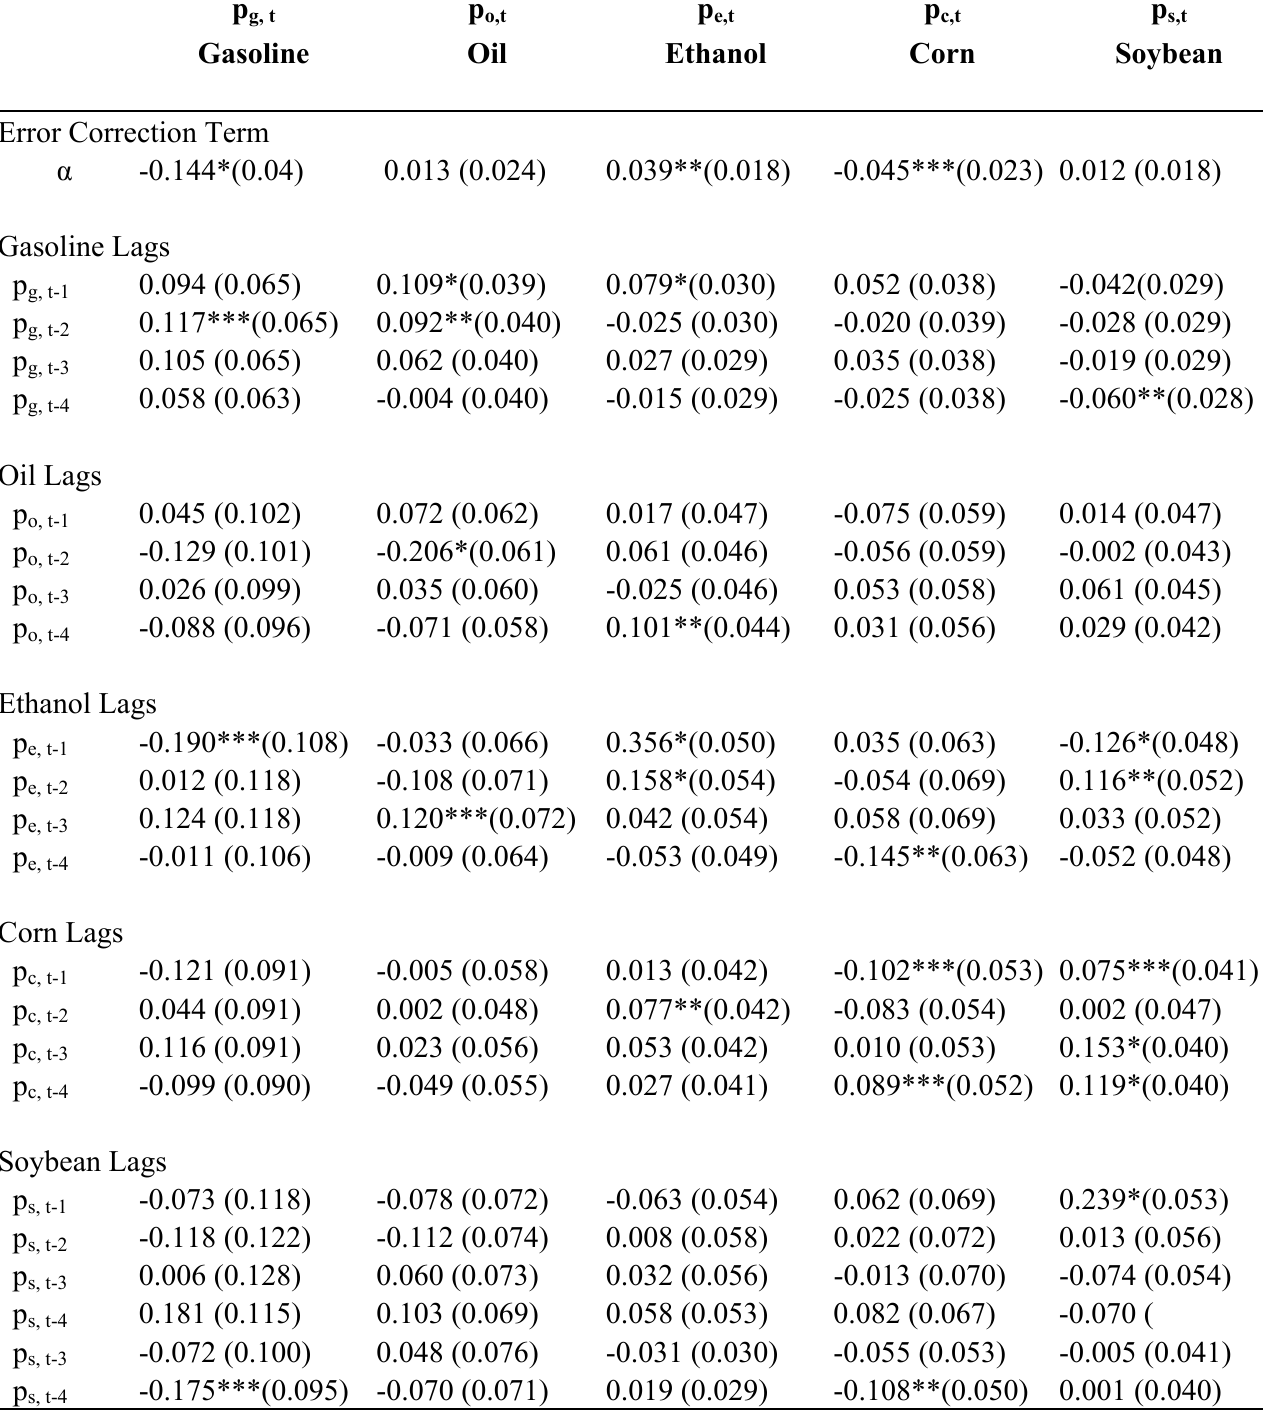
Table A2. Ethanol Boom, 2000-2007 VECM